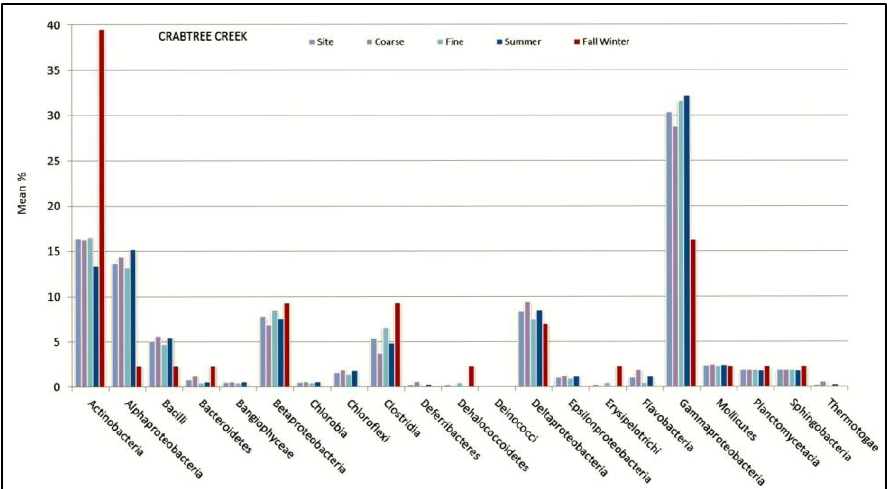
Figure 5. Crabtree Creek mean % values of OTU matches for bacterial class represented by sediment size and seasonal sampling